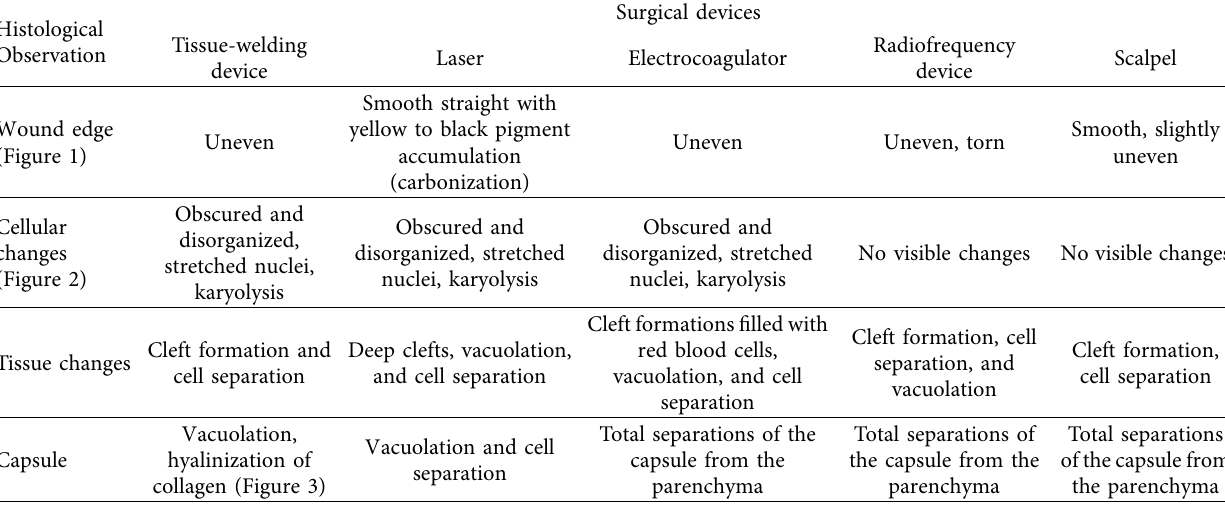
Table 1: Tissue changes caused by various surgical devices immediately after